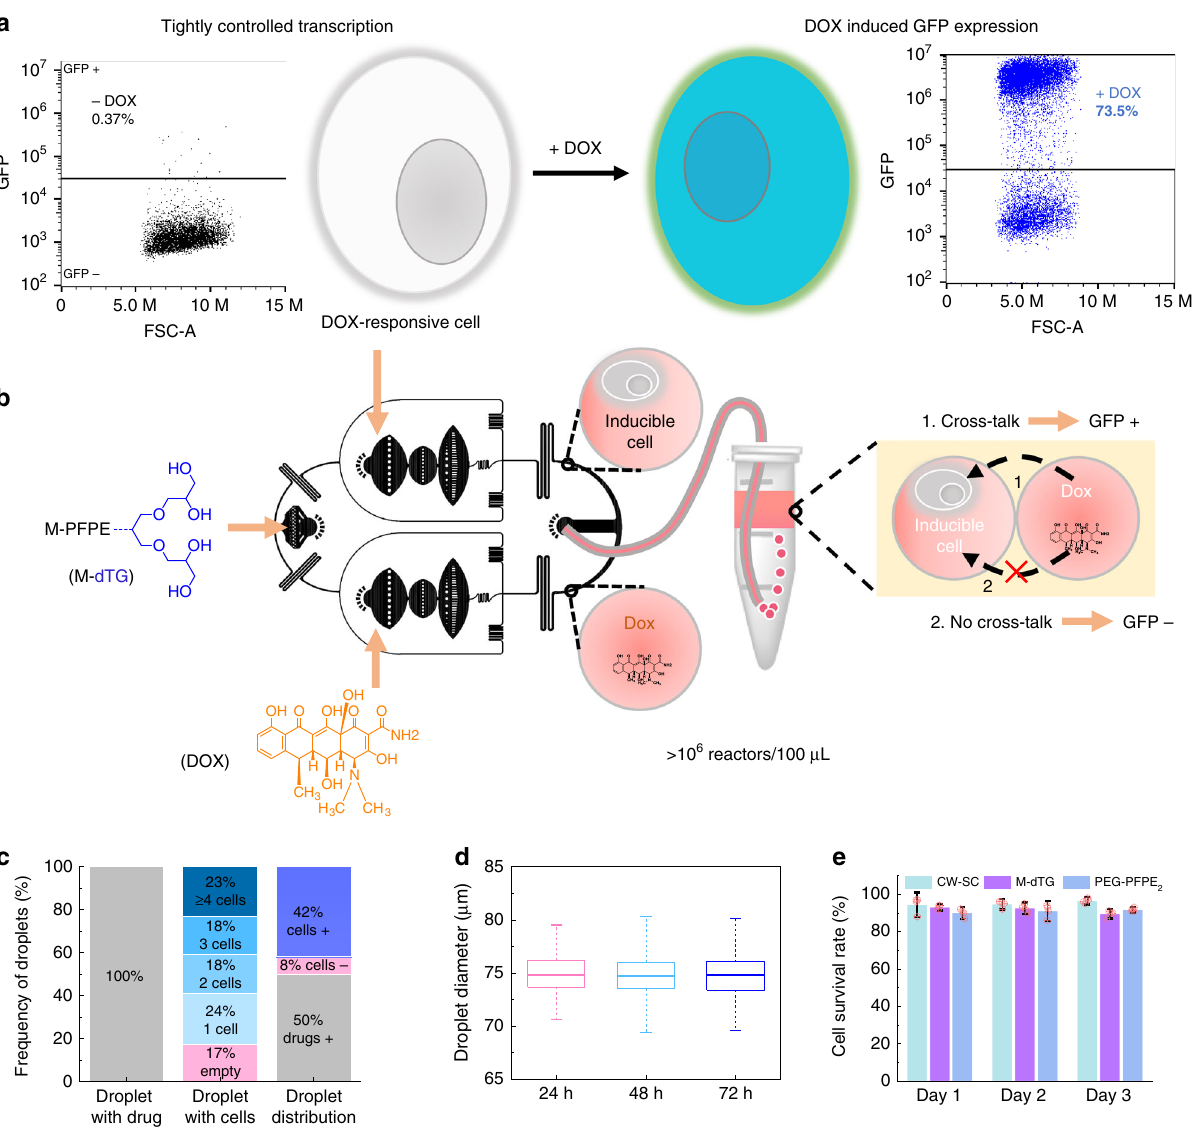
Fig. 4 Cell-based reporter system to test inter-droplet drug diffusion. a HEK 293 cells stably transfected with a doxycycline responsive GFP reporter construct (reporter cells) show no GFP expression in the absence of drugs and become highly fl uorescent after 48 h incubation in the presence of 500 nM DOX-solution. b Homogeneous population of DOX-containing droplets and Reporter-cell-containing droplets was generated using a parallel drop maker that creates an equal number of droplets from two independent aqueous streams. c Cell-loading into droplets roughly follows Poisson predictions. We imaged 533 droplets immediately after cell encapsulation to determine cell occupancy. We used an input density of fi ve cells per droplet volume and found that 83% of the droplets contained one or more cells. Therefore, with cells at this concentration, the parallel drop maker generates a mixed droplet population in which 42% droplets contain one or more cells, 50% contain only doxycycline, and 8% are empty. d Box-plot of droplet size distribution after 24, 48, and 72 h incubation at 37 °C demonstrates that the mean average droplet diameter remained constant (~75 µ m) over the time course ( n = 204 – 226 droplets for each time point). The box plots represent the median (center line), the interquartile range (box) and mean ± 1.5 x s.d. (whisker). e Viability of cells cultured in wells or in droplets. As a positive control we cultured cells at standard concentration in culture wells (CW – SC) (1 × 10 6 cells/ ml). We used M-dTG and PEG-PFPE 2 surfactants to generate cell encapsulated droplets and incubated droplets at 37 °C for the indicated times. We isolated cells from the droplets to perform live/dead assay using Calcein AM and Ethidium Homodimer-1 dyes based live/dead cell viability assay kit (Invitrogen). We counted ~500 – 2000 cells to estimate the cell survival rate at the indicted time points. Data are presented as mean ± s.d., n = 4 images from distinct areas. Source data of c – e are provided as a Source Data fi and to analyze the GFP expressing cells, respectively. Flow cytometry data is calibrate the recorded peak. To record IR spectra, Nicolet AVATAR 320 FT-IR 5 analyzed using FlowJo v10. Homemade MATLAB scripts are used to analyze SXC (Thermo Fisher Scienti fi c, USA) is used with a DTGS detector from 4000 to droplet size distribution by fi nding droplet circles and extracting the corresponding 650 cm − 1 wavenumbers. Bright fi eld and fl uorescence imaging are obtained with diameters that are adjusted to fi nal diameter according to the actual pixel size of the Zeiss Axio Observer (Germany) and Leica confocal microscope (TCS SP8, image. OriginPro 2019b (Academic) was used to prepare Boxplots and bar charts. Germany). To record green fl uorescence signals, 488 nm excitation wavelength is used, and the emission signals are detected by a 520/55 nm band pass fi lter. A high- speed Phantom MIRO ex2 camera (Vision Research, USA) is employed for bright fi eld imaging during micro fl uidic droplet preparation. FACSAria ΙΙΙ (USA) cell sorter and BD Accuri ™ C6 Plus (USA) fl ow cytometer are used for cell sorting